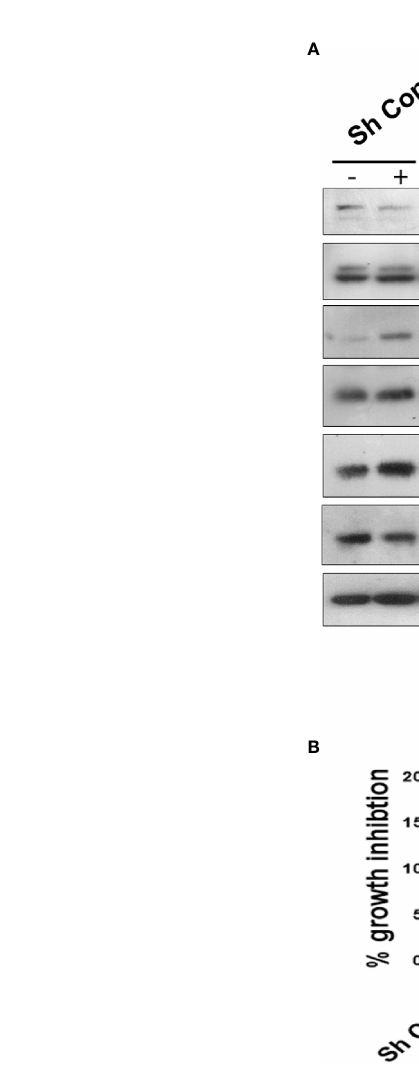
FIGURE 9 | Knock-down of IL6R a abolishes the apoptotic activity of SSTP1. (A) HSC-4 cells stably expressing either control shRNA or IL6R a shRNA were treated with SSTP1(10 m M) for 30 minutes and western blot was performed for the indicated molecules. The relative phosphorylation based on untreated control ShRNA is plotted. (B) The control and IL6R a - knocked-down cells were treated with SSTP1 for 4h and MTT was performed. The percentage growth inhibition based on the untreated cells is plotted. The western blot showing the knock-down is also shown. *p < .05, **p < .01, ***p <